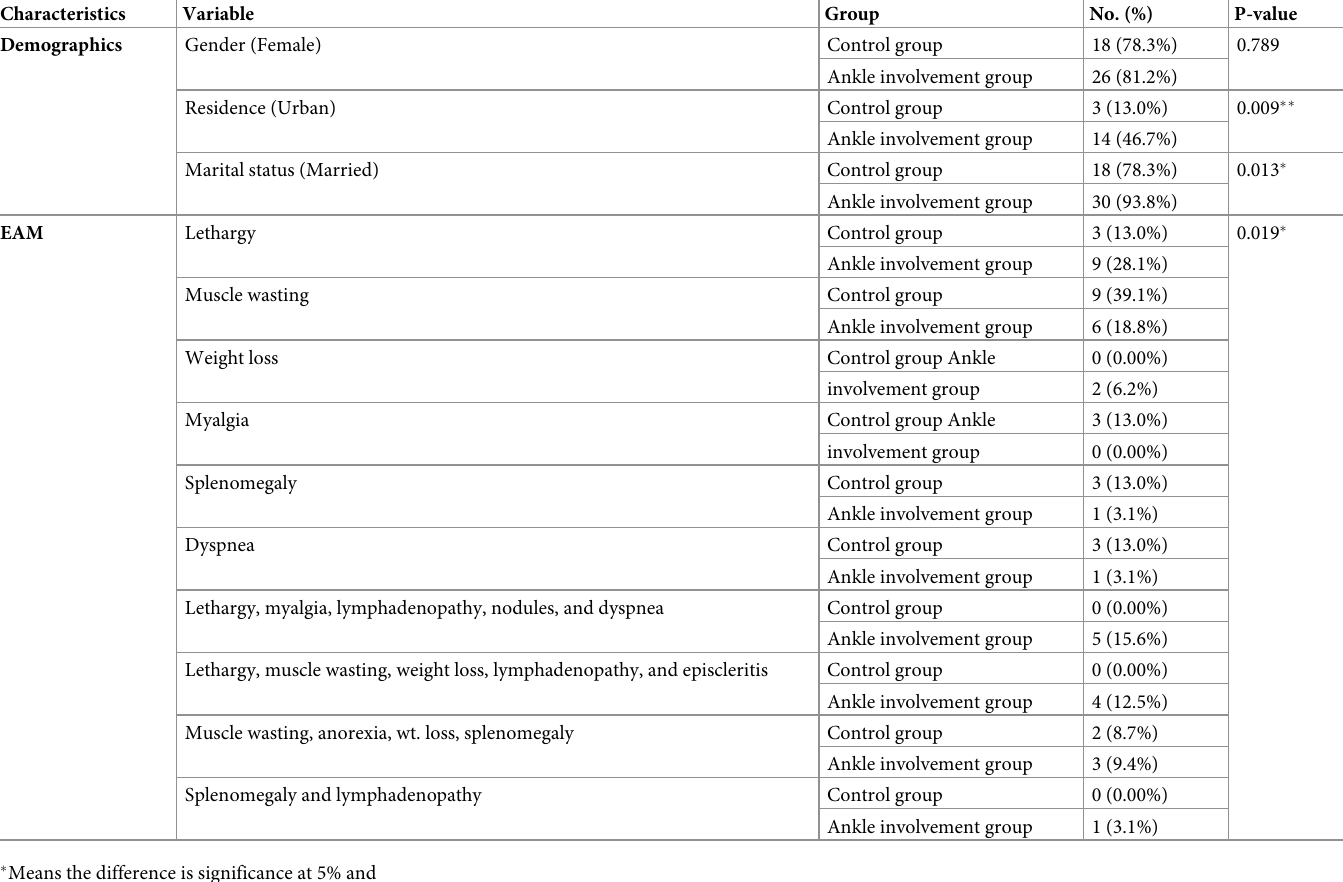
Table 1. Differences in demographic characteristics and extra-articular manifestations (EAM) among rheumatoid arthritis patients for the two study groups: The control group (patients without ankle involvement, n = 23) and ankle involvement group (patients with ankle involvement, n = 32) along with the p-value of the x 2 -